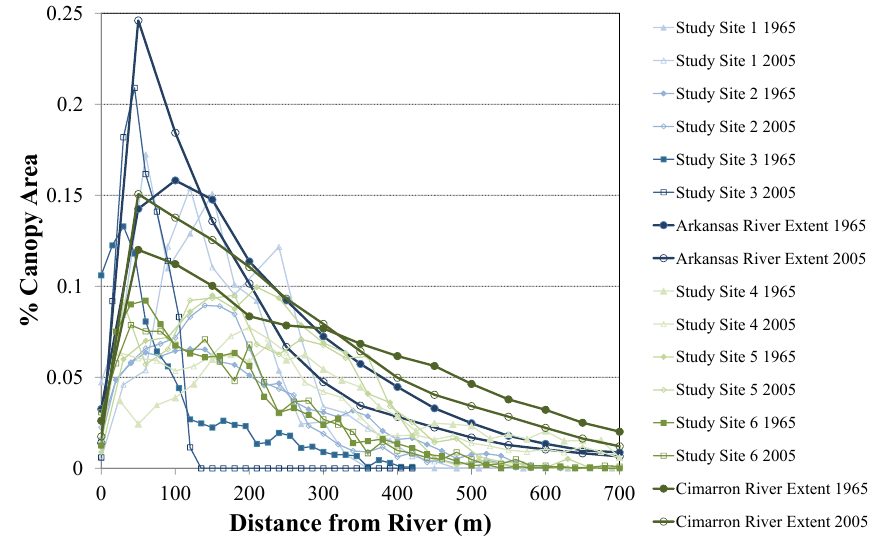
Fig. 4. The distance from phreatophytes to the stream channel in the six study sites and the river corridors. and Shape: Area Compactness (all dir.) was created for both river corridors, pre- and